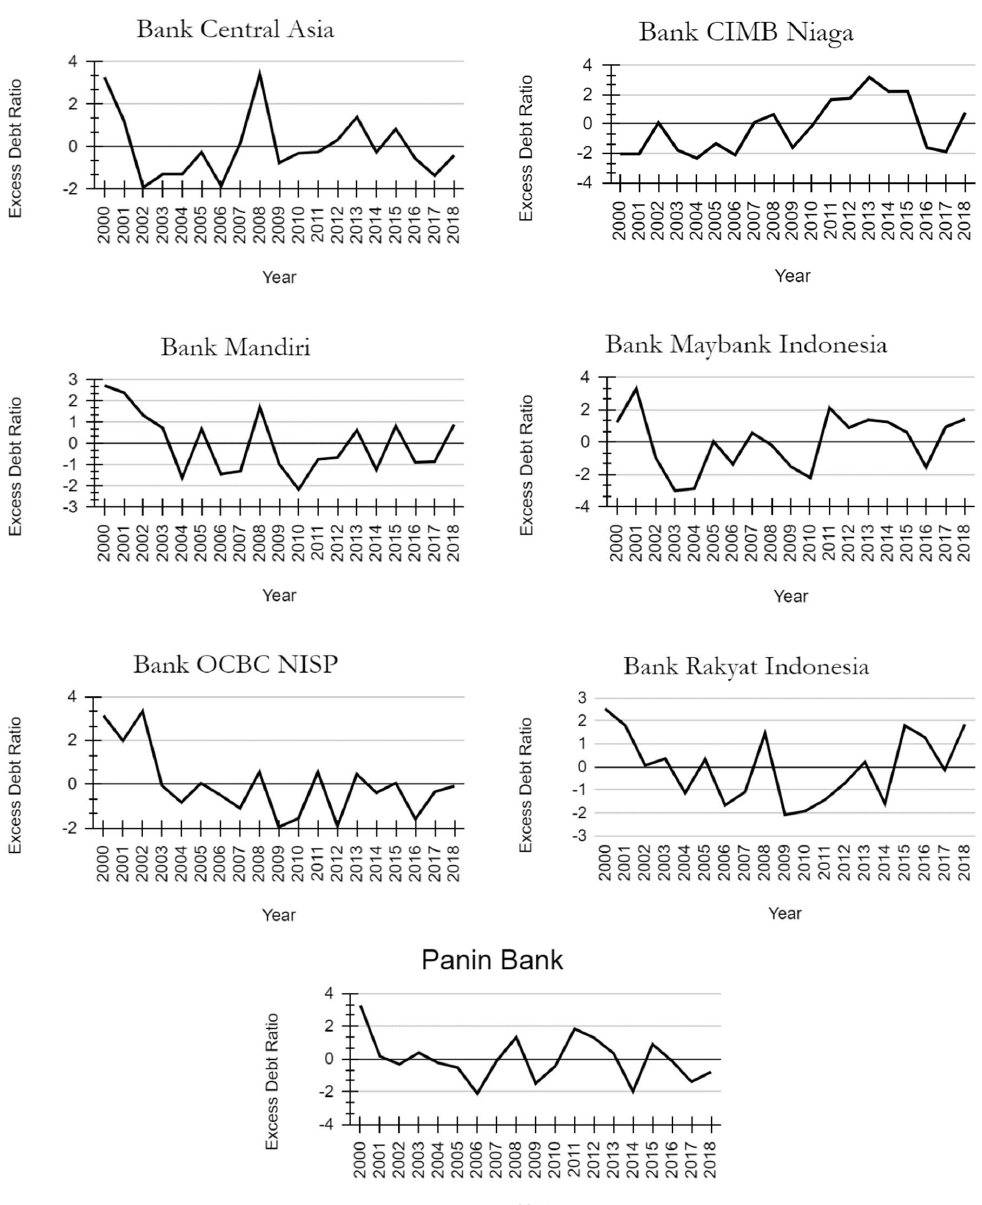
Figure 3. Excess debt ratios for conventional banks. Source: author’s calculations.